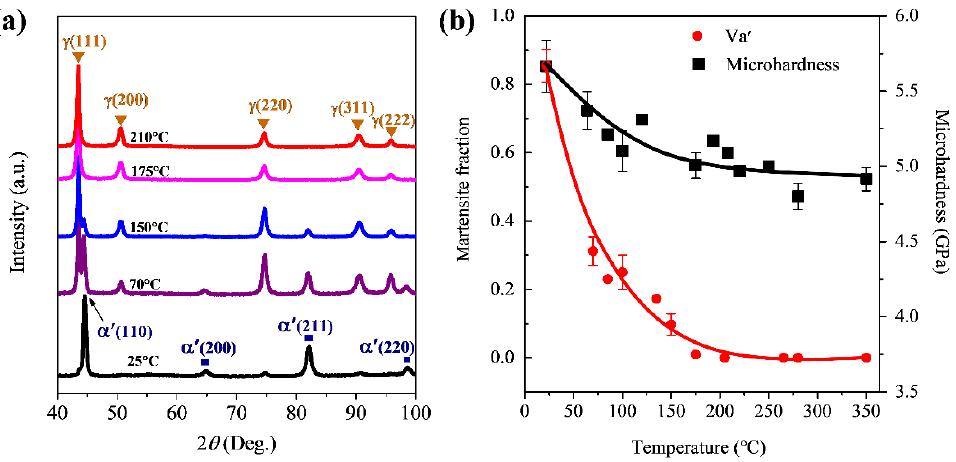
Figure 4. ( a ) XRD patterns measured on SMRT samples prepared at different temperatures as indicated. ( b ) Variations of martensite volume fraction and microhardness with temperature in the near-surface layer of SMRT samples.